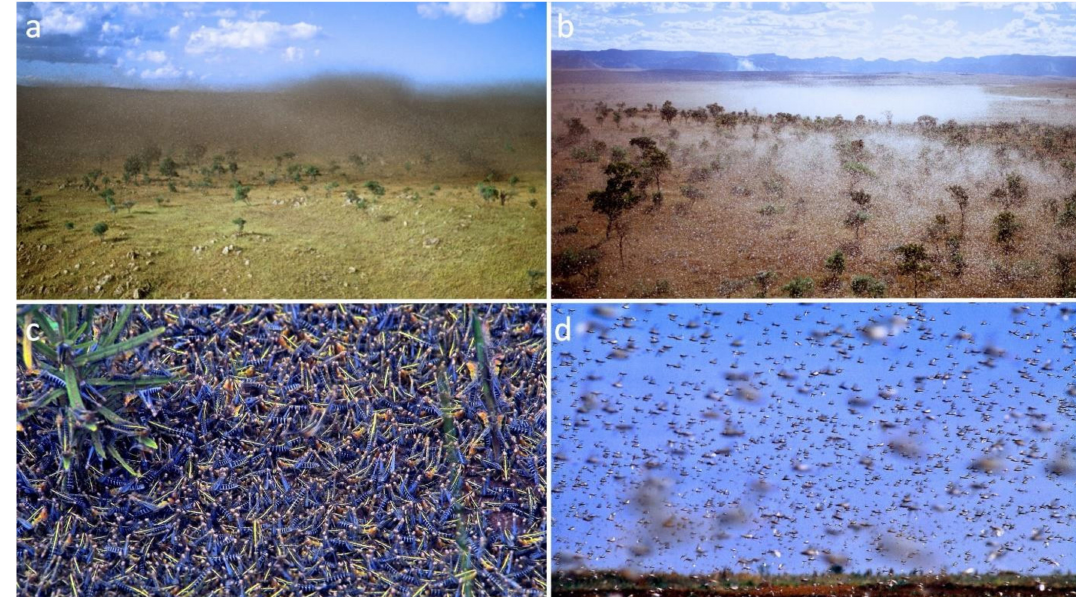
Figure 1. Example of locust swarms and hopper bands: the Migratory Locust, Locusta migratoria , in Madagascar ( a , b ) and the Mato Grosso Locust, Rhammatocerus schistocercoides , in Brazil ( c , d ) (photos M. Lecoq). The Migratory Locust swarm is approximately 5 × 2 km, measured from a helicopter, and it completely covers the landscape due to its high density. Its color varies according to the position